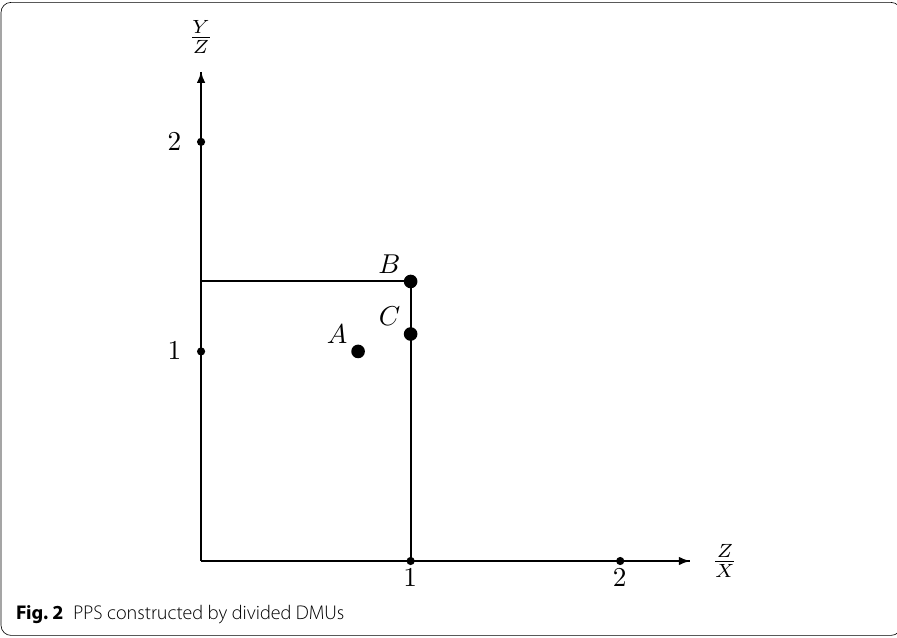
Fig. 2 PPS constructed by divided DMUs